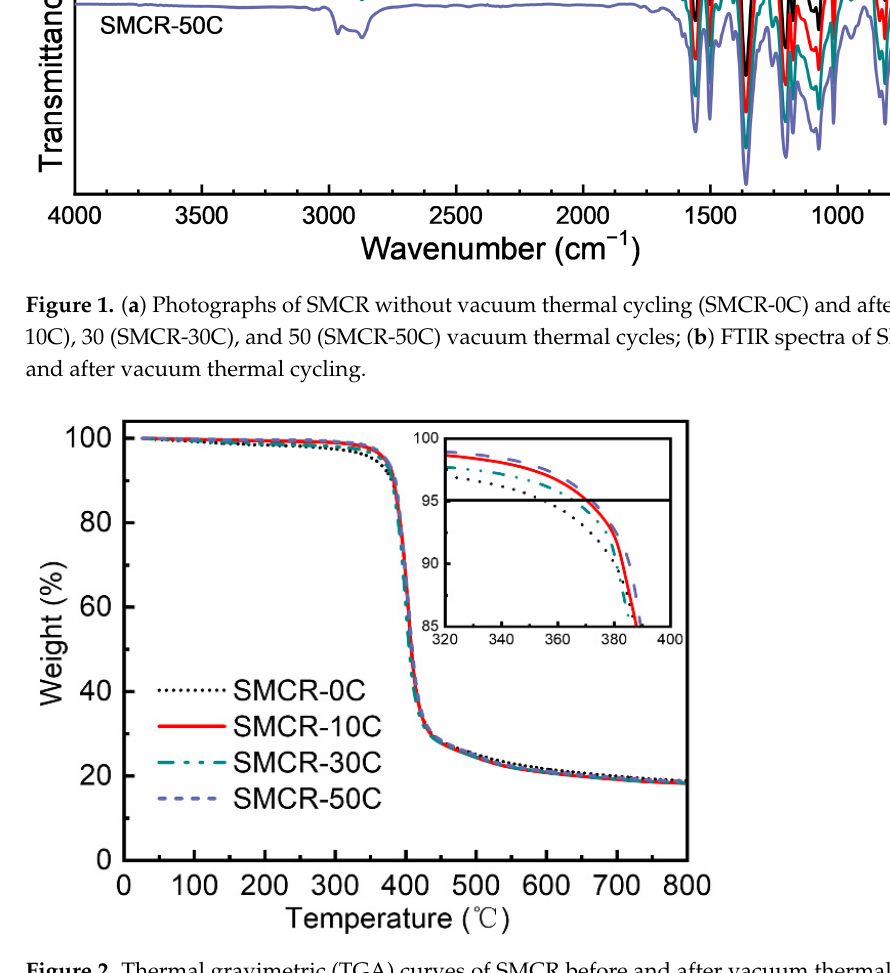
Figure 1. ( a ) Photographs of SMCR without vacuum thermal cycling (SMCR-0C) and after 10 (SMCR-10C), 30 (SMCR-30C), and 50 (SMCR-50C) vacuum thermal cycles; ( b ) FTIR spectra of SMCR before and after vacuum thermal cycling.